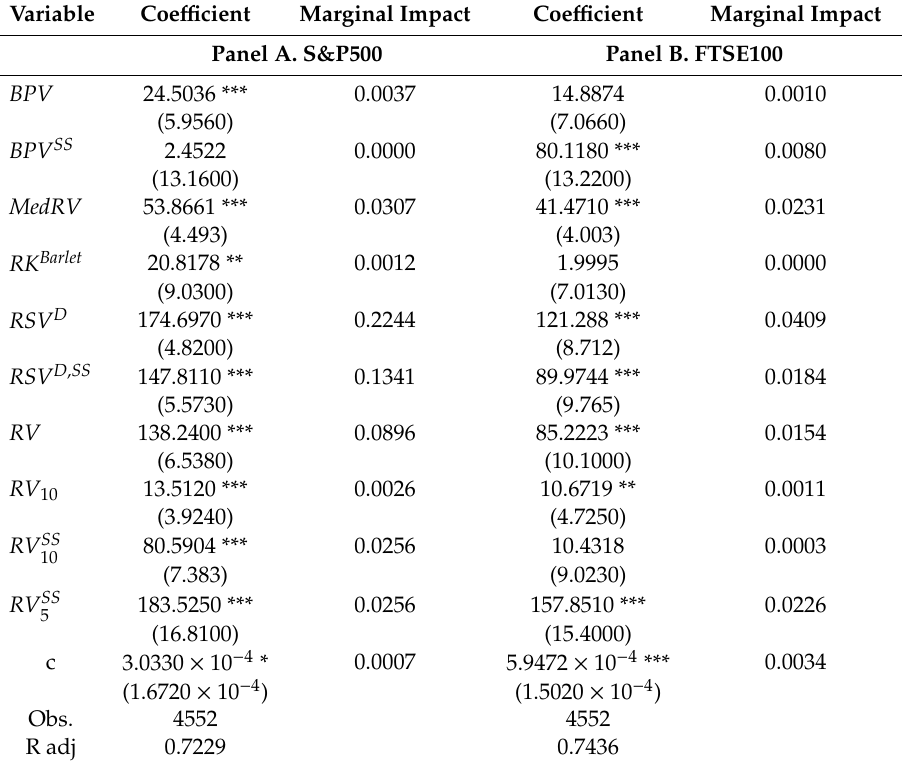
Table 2. Hypothesis 1 (volatility feedback e ff ect) regression